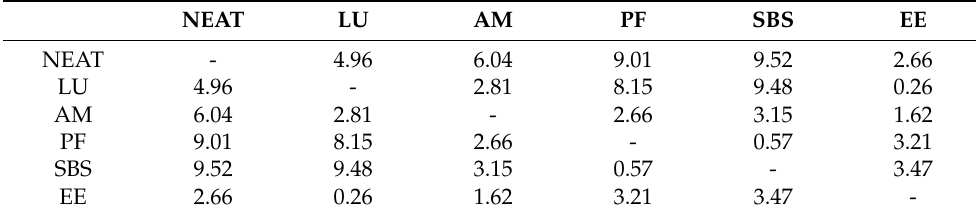
Table 8. Effect sizes dynamic modulus at the temperature of − 10 ◦ C.